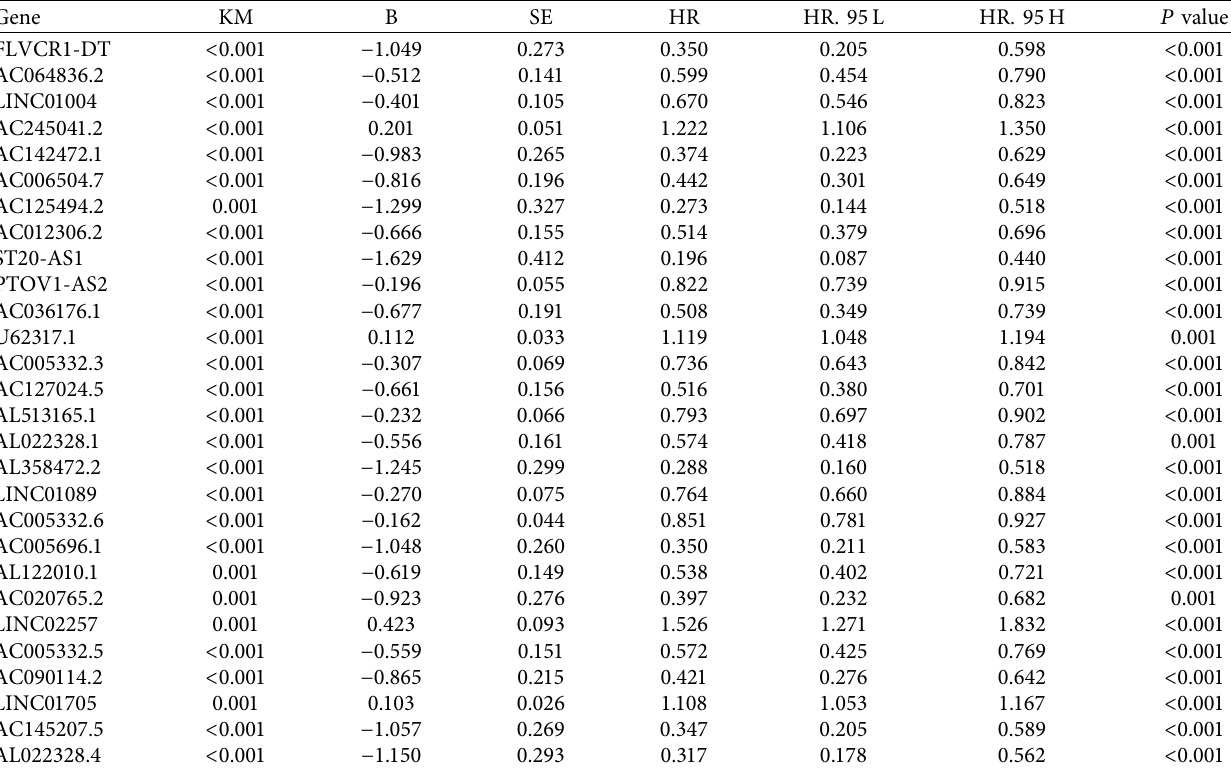
Table 1: Univariate Cox analysis showed that 28 autophagy-related lncRNAs were significantly related to the survival of PC patients. Gene KM